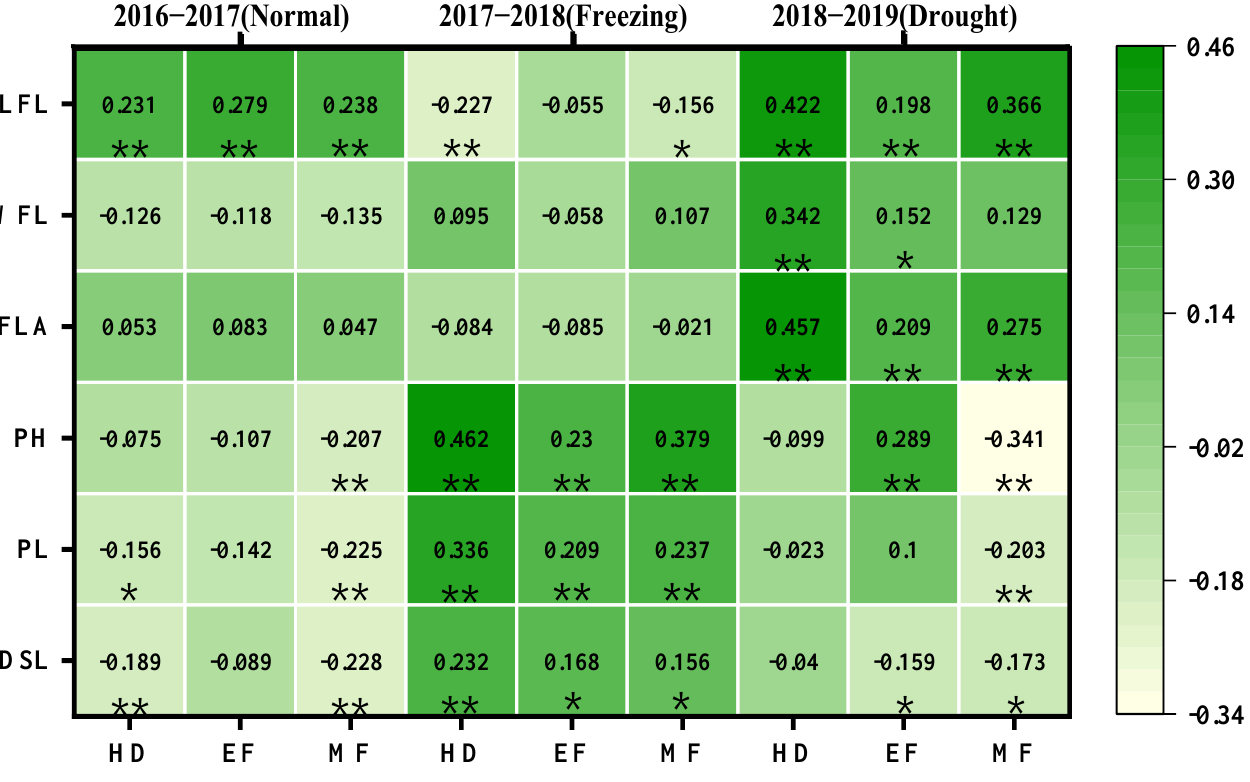
Figure 4. The correlation coefficients between CTDs at three growth stages with the canopy structural traits of three growing seasons. The correlations were estimated using the Pearson correlations from the SPSS; * and ** indicate the correlations significant for p < 0.05 and p < 0.01, respectively. WFL: width of flag leaf; LFL: length of flag leaf; FLA: flag leaf area; PH: plant height; PL: peduncle length; DSL: distance from spike to leaves; HD: heading; EF: early filling; MF: middle filling.